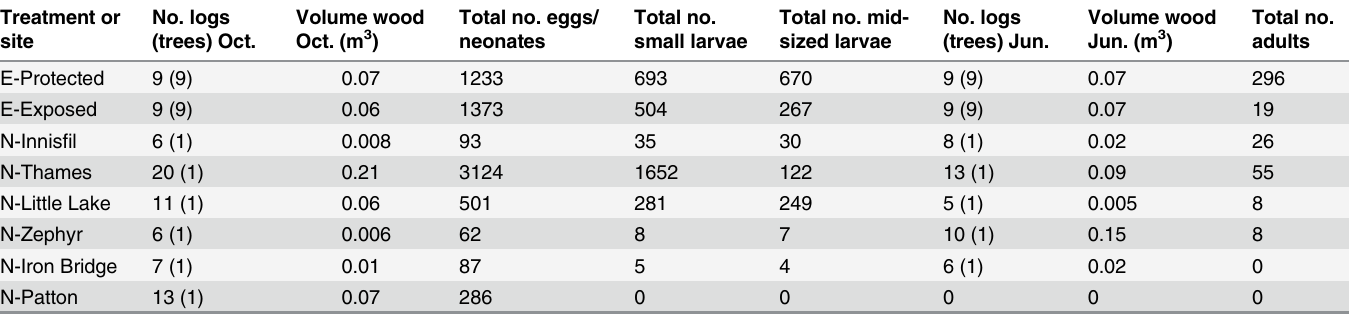
Table 2. Number of logs and different trees ( Pinus sylvestris ) collected for Sirex life tables and the actual number of surviving insects recovered from each life stage. Treatment or No. logs site (trees) Oct.